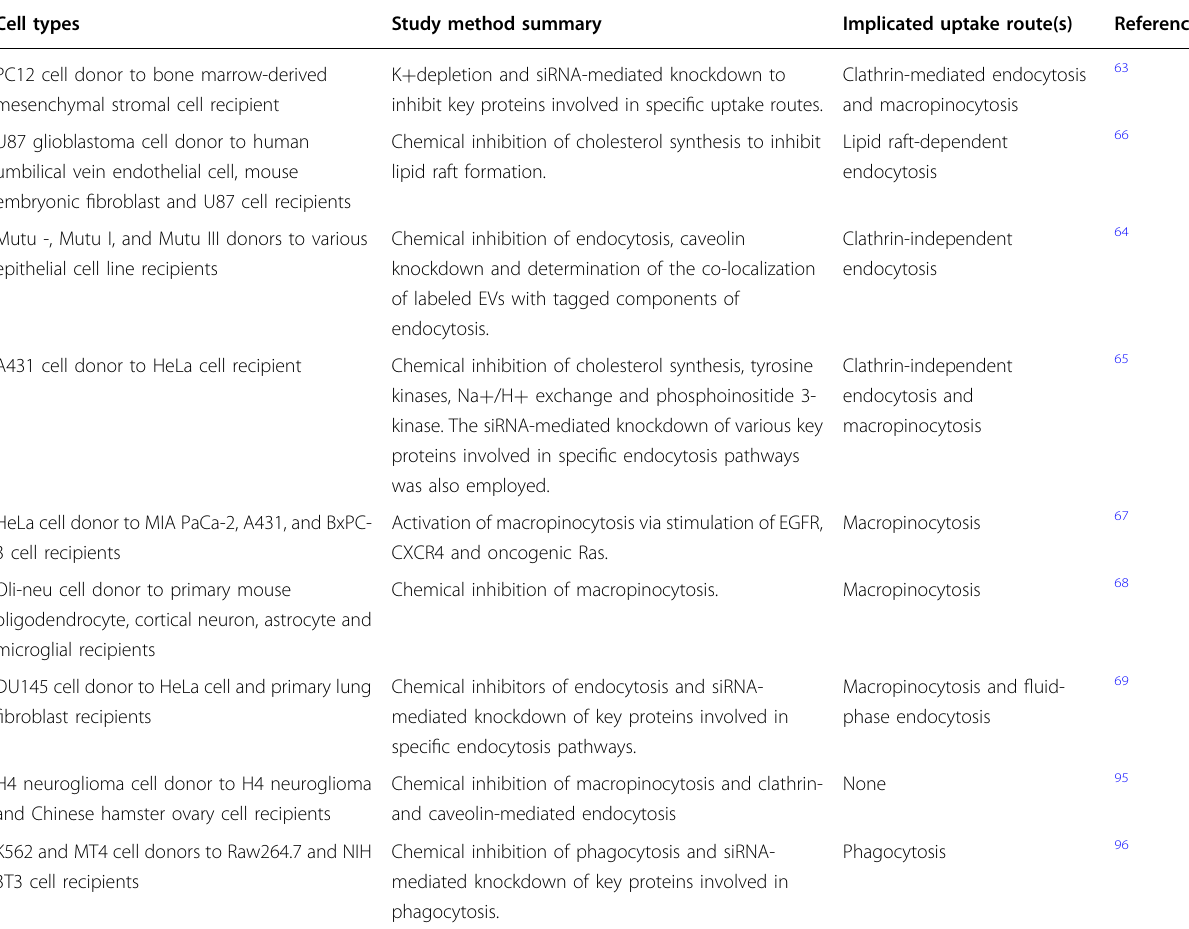
Table 2 An overview of research into EV uptake routes Cell